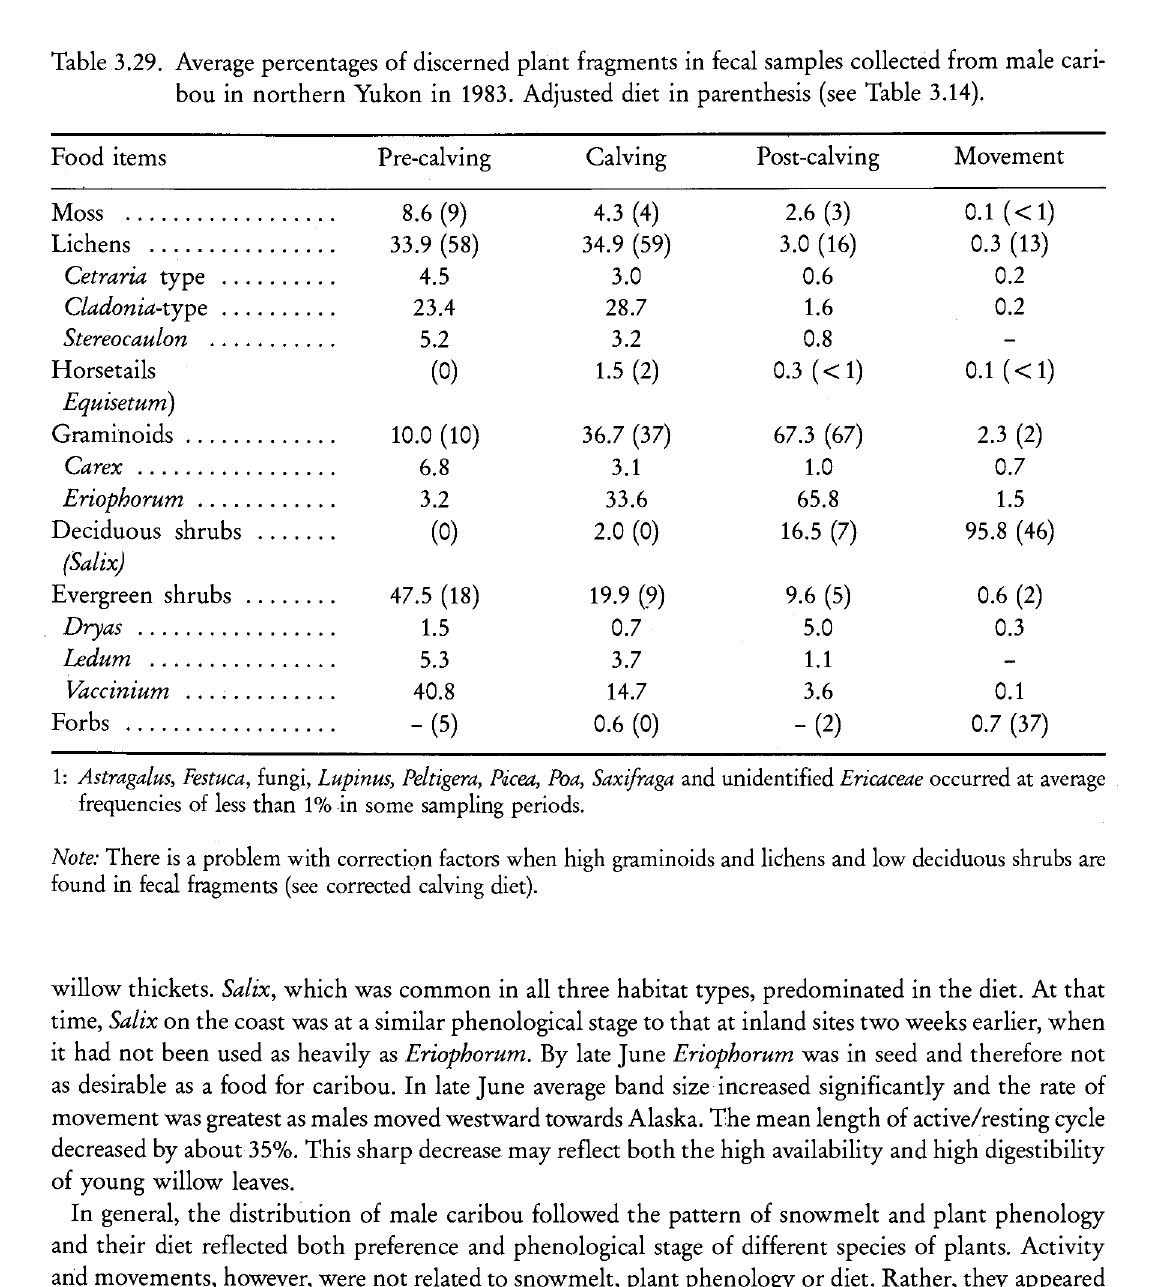
Table 3.29. Average percentages of discerned plant fragments in fecal samples collected from male cari bou in northern Yukon in 1983. Adjusted diet in parenthesis (see Table 3.14). Food